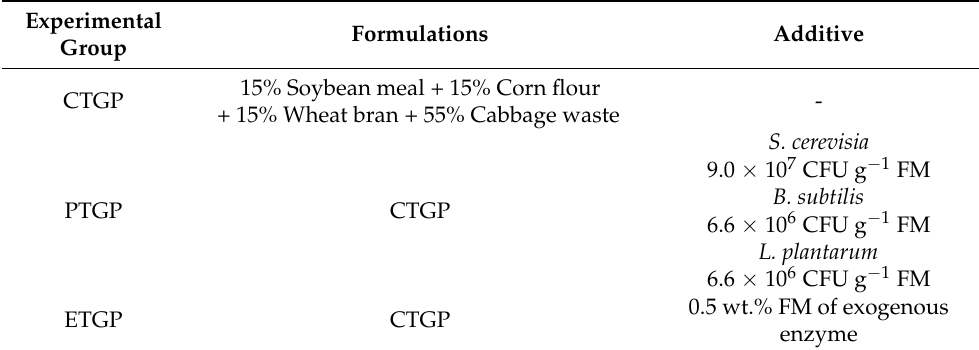
Table 2. The formulations in every bag of the three fermentation treatment